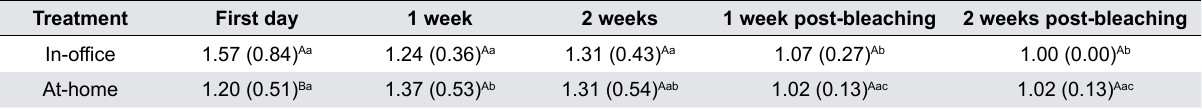
Table 4- Means (SD) values for weekly tooth sensitivity and degrees of tooth sensitivity reported by volunteers in different treatment groups